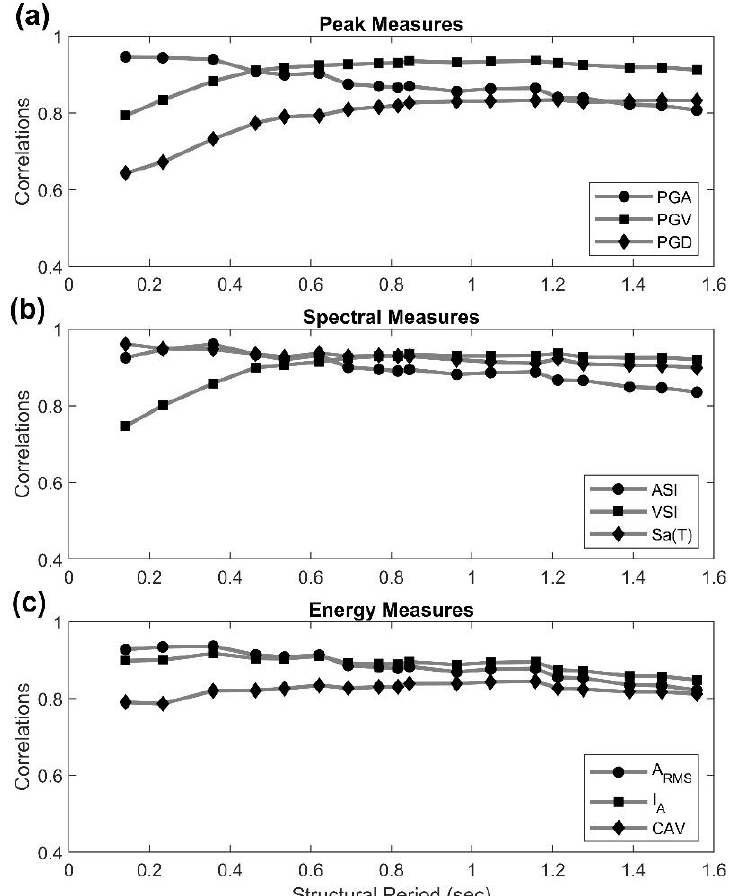
Figure 6. Correlations between IMs and EDPs as a function of structural period. ( a – c ) are for peak, spectral and energy measures, respectively. PGA and PGV exhibit good correlation; PGA decreases with period. The correlation with PGV increases with period, with a slight decrease beyond 1.2 s; the correlation with PGD is moderate and increases with period. Among the spectral measures, the correlation for ASI is similar to that of PGA , and VSI is similar to that of PGV . For long period structures, correlation with VSI remains almost constant. Sa(T) shows strong correlation for short-period frames and remains constant for longer periods. Among the energy measures, A RMS and I A decrease with periods, while CAV remains approximately constant.